Question: Express in one sentence what the figure is showing.
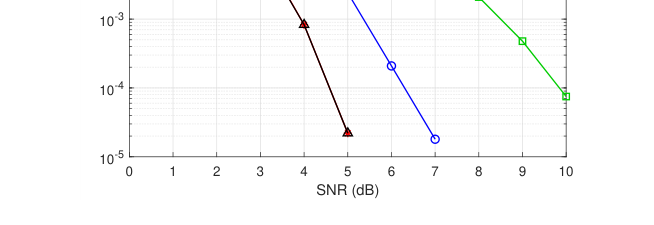
Answer: compares the BER performance for different de- coding schemes in the AWGN channel. The proposed soft- decision detection schemes with exact LLR values achieve the best detection performance. As the channel knowledge and the noise variance value are difficult to obtain in practice, we also use the approximate LLR value to simplify the process. The soft decision scheme with approximate LLR achieves a performance that is tightly close to that with the exact LLR value. This experiment suggests that in practice there is no need to perform channel and noise variance estimation at the low- power receiver side which further reduces the complexity and power consumption. Simply using the soft decision detection with approximate LLR value guarantees a satisfactory perfor- mance. Moreover, compared with hard decision detection, soft decision detection achieves around 1.5 dB gain at 0.1% BER in AWGN channels. Compared with direct transmission without